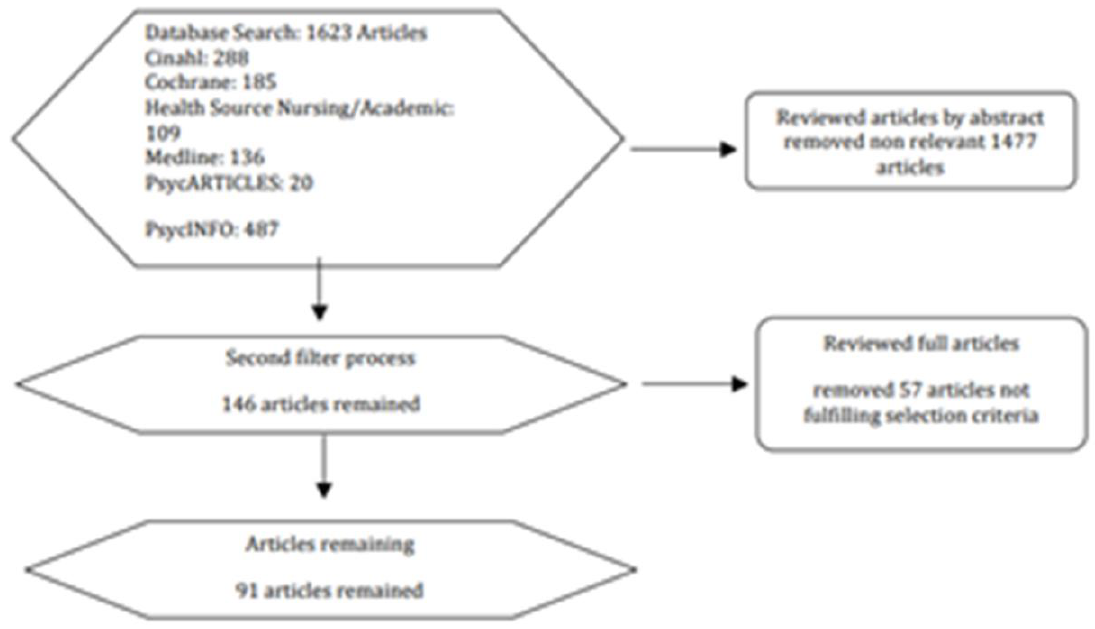
Figure 1. Literature review filtering